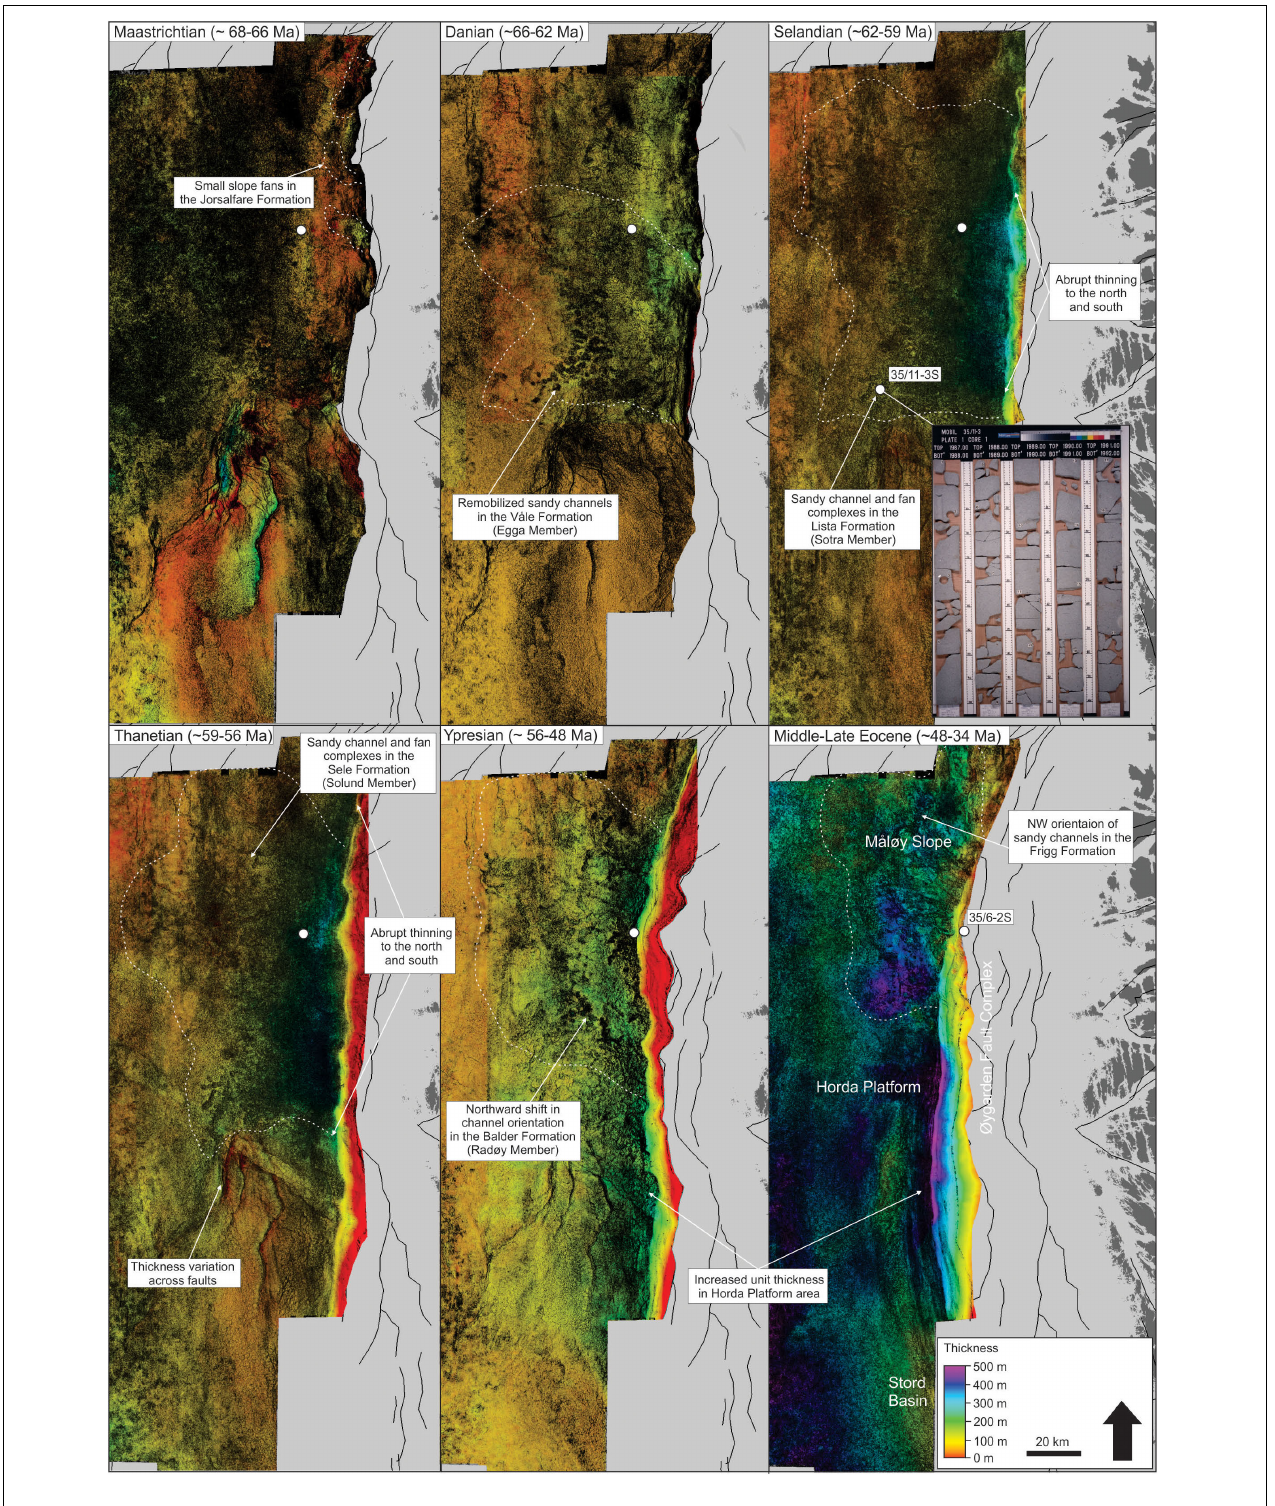
FIGURE 3 | Co-blended variance and isopach maps of the Maastrichtian to Eocene stratigraphic units. The approximate extent of the slope to deep-water fan systems is shown by a white hatched line. Maastrichtian fans are not drilled, but indicated from small channel-lobe geometries in attribute maps. High input of coarse-grained material in the Våle, Sotra and Lista Formations is well documented. Inset shows cored example of a sandy, deep-water channel in the Lista Formation (Sotra Member). Image from www.npd.no. Sandy channels are recognized by linear features in the variance blend (black shading). Note the shift from a localized, point-sourced depocenter in the Paleocene to a more lateral extensive depocenter in the Ypresian coinciding with onlap and redistribution of sediment along strike after the PETM.